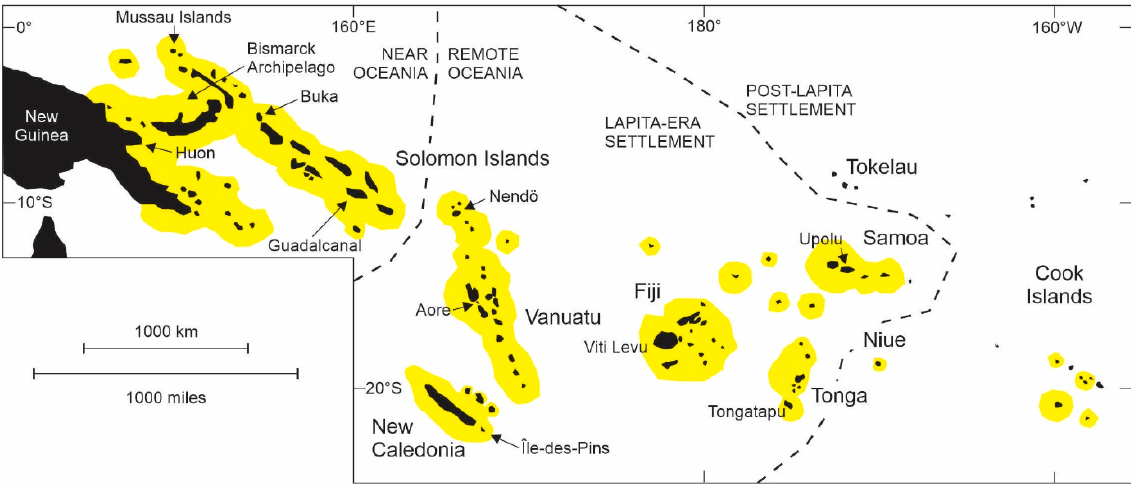
Figure 1. The earliest (Lapita) settlers on islands in the southwest Pacific moved out from the Bismarck Archipelago (Papua New Guinea) about 3300 years ago (cal BP), bypassed the main group of Solomon Islands, to occupy Nendö (eastern outer Solomons), New Caledonia and Vanuatu, before crossing at least 900 km of open ocean to reach Fiji perhaps 3050 years ago, and reaching Samoa and Tonga before the end of Lapita culture (marked by the end of pottery decoration) about 2500 years ago.